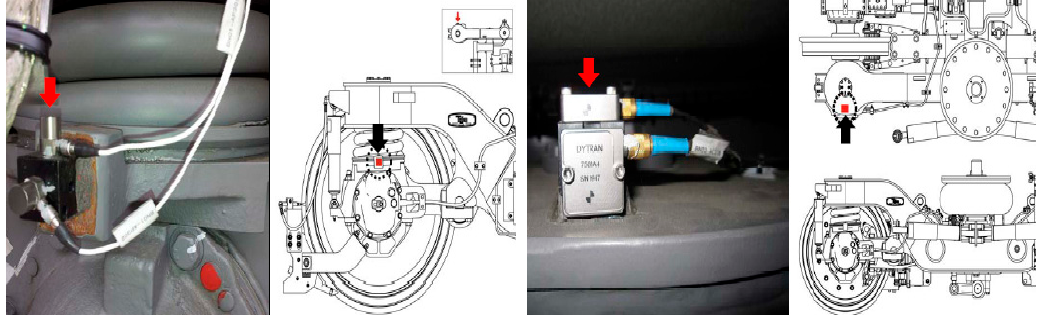
Figure 1. The sensor installation position on the axle and bogie of a high-speed train: Top: High-speed train for this research (left), the bogie of the high-speed train (right), Bottom: The sensor at the axle box (left), the sensor at the bogie frame (right).